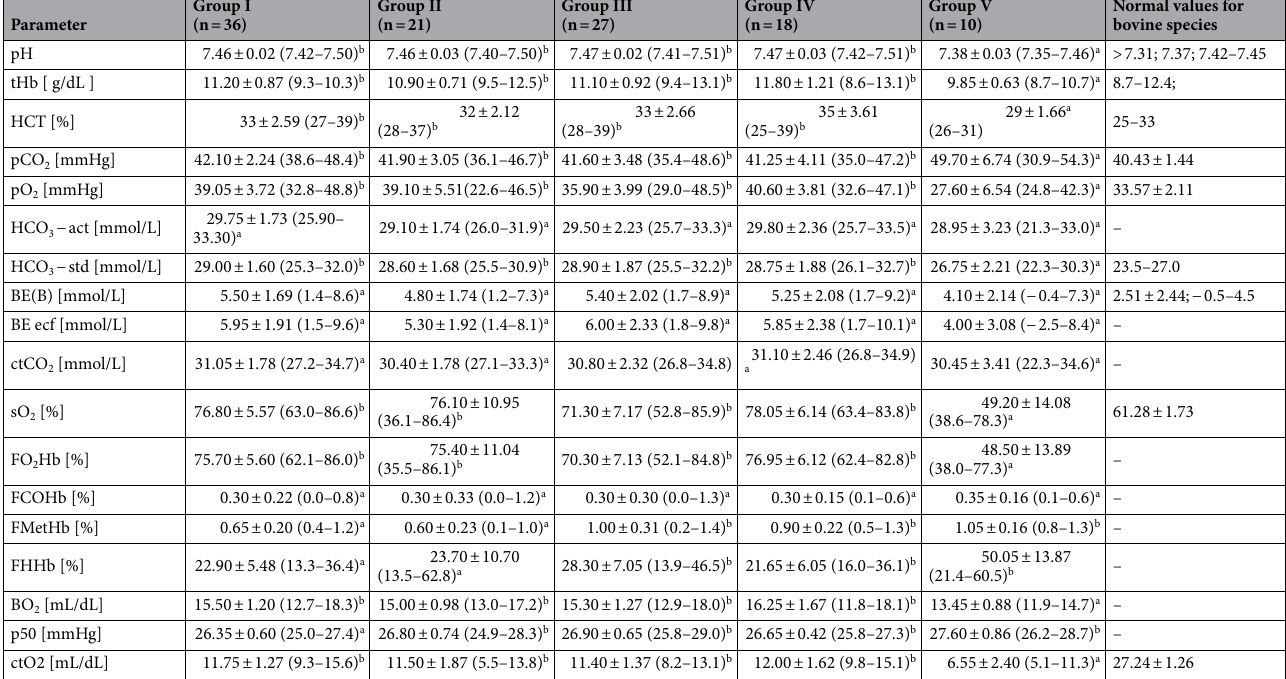
Table 3. Blood gasometrical parameters (median, SD, minimal, and maximal values) in different groups of dairy cattle compared with the normal values for cattle (according to Sayers et al. 2016 31 , Wood et al. 2010 40 , Temiz et al. 2014 37 , Indrova et al. 2020 20 , Cornell Animal Health Diagnostic Center 42 ). The cows were divided in to five groups: I—44 kg milk/cow; II—38 kg milk/cow; III—30 kg milk/cow; IV—25 kg milk/cow; and V—19 kg milk/cow, based on mean daily milk yield. Means with different letters (a–b) are different ( P < 0.05).